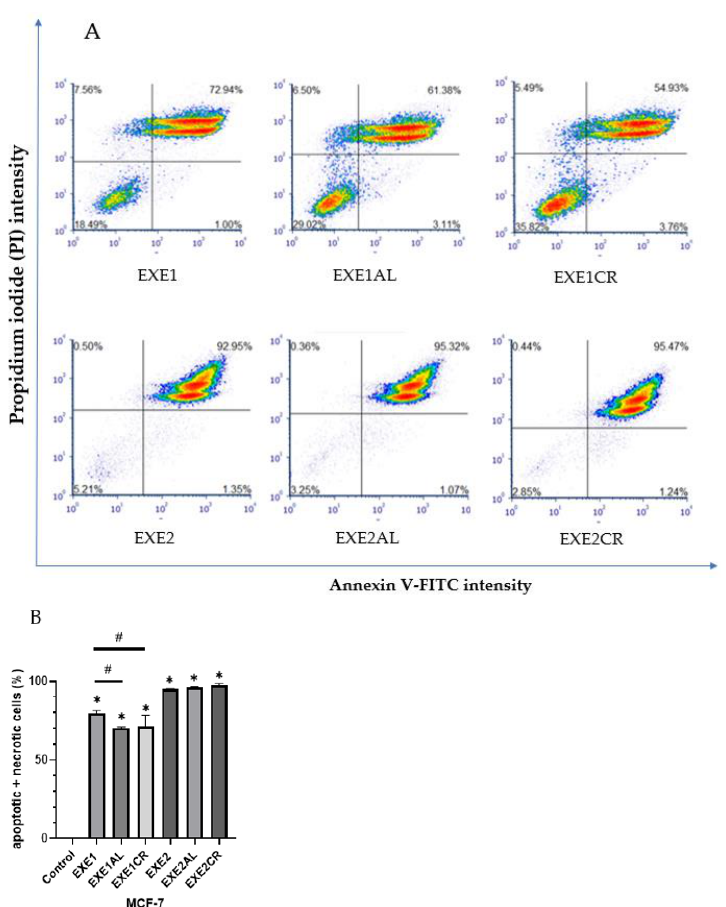
Figure 2. Effect of exemestane alone and in combination with metalloestrogens on MCF-7 cell death. ( A ) Representative cytograms of flow cytometric are shown. EXE1 = 100 µM; EXE2 = 200 µM; Al./Cr(III) = 100 µM. ( B ) Percentage of both apoptotic (early and late apoptotic) and necrotic cells. The results are presented as mean ± SD, n = 3; p < 0.05; * statistically significant difference from control; # statistically significant difference from aromatase inhibitor alone.